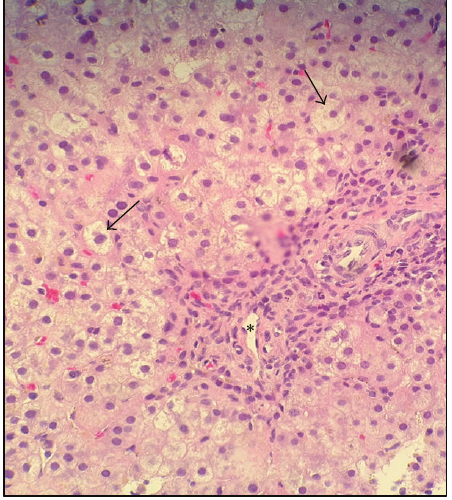
Figure 1: Liver biopsy at 100x magnification showing bile duct plugs (arrows) along with multinuclear giant/hydropic cells.